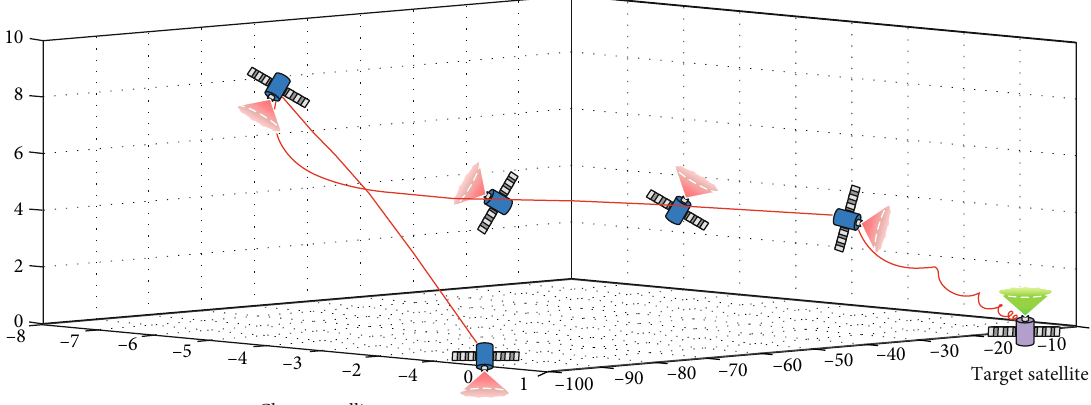
Figure 7: 3-D overall trajectory of close proximity maneuver via